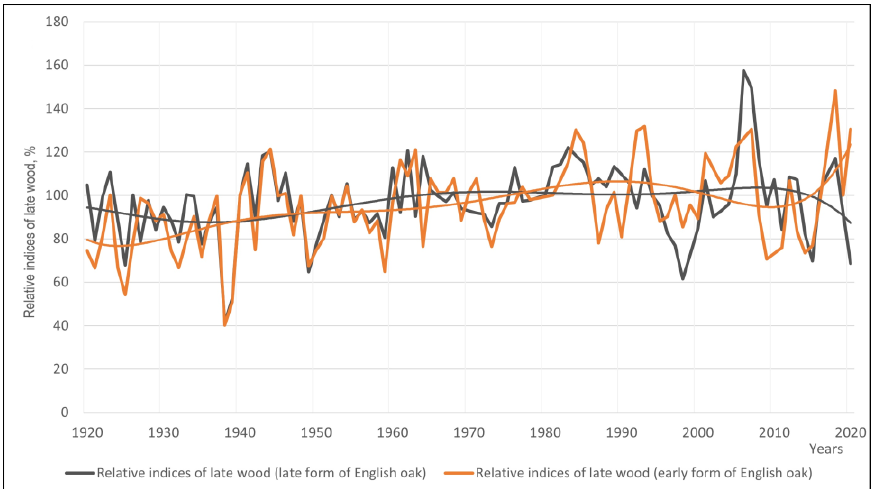
Figure 6. Long-term dynamics of ARW in two phenological forms of English oak on solonetzic soils.